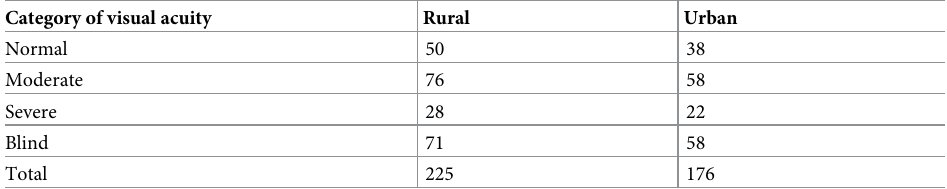
Table 3. Comparison between the place of residence against visual impairment.